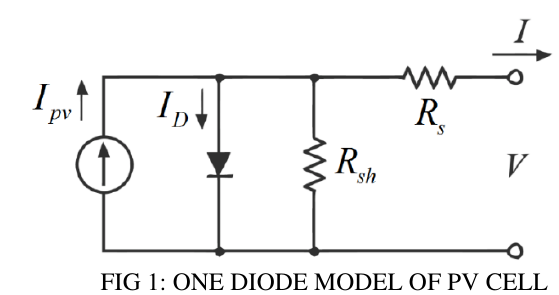
FIG 1: ONE DIODE MODEL OF PV